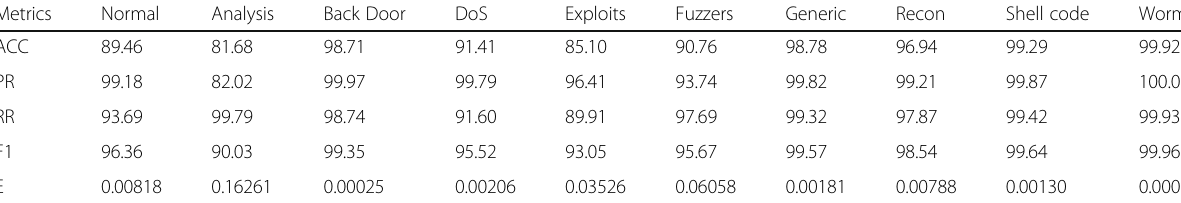
Table 6 Performance Metrics of the Model for UNSW_NB15 Dataset using lr = 0.1 Metrics